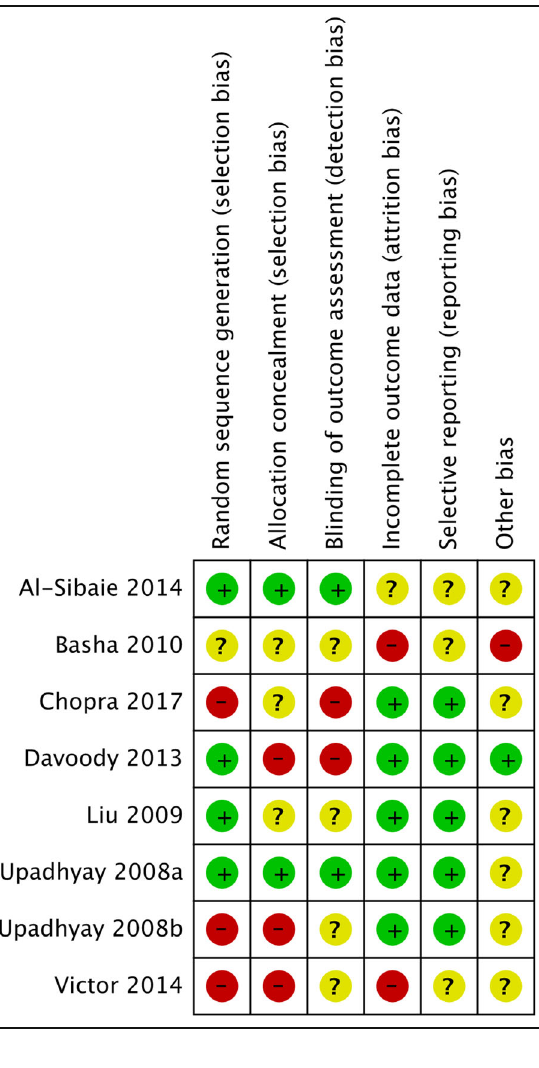
Table 3 Risk of bias judgment according to the Cochrane